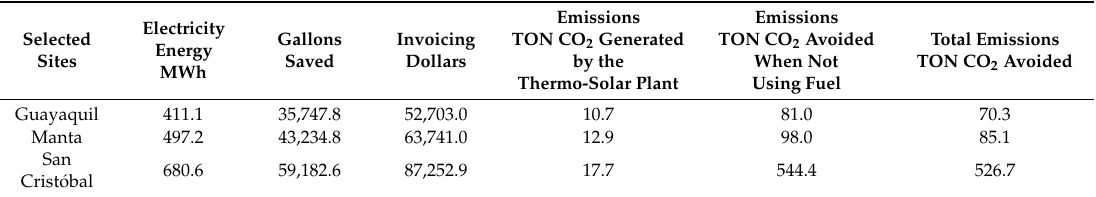
Table 7. CO 2 emissions avoided by the generation of thermo-solar